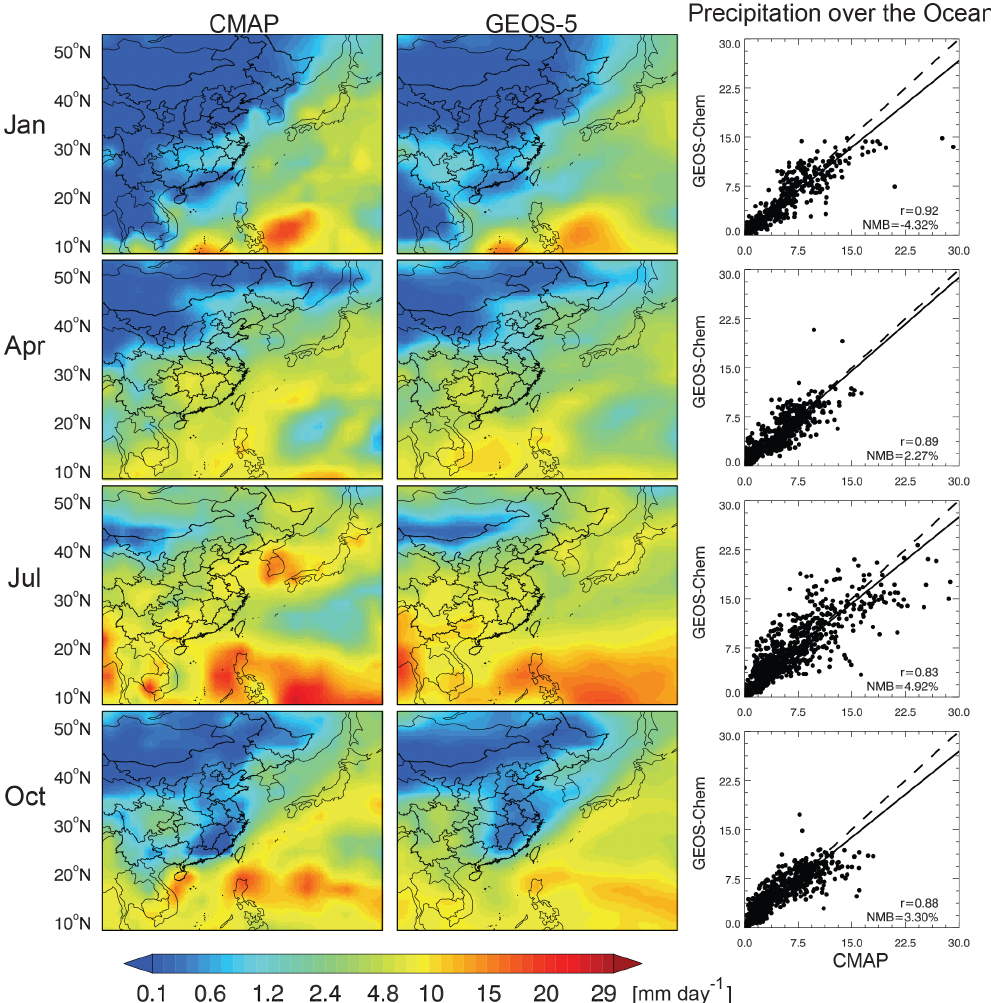
Figure 4. Monthly mean precipitation data from CMAP (left panels) and from GEOS-5 (central panels) for January, April, July, and Octo- ber 2009. The right panels show corresponding scatter plots of CMAP versus GEOS-5 precipitation over the northwestern Pacific Ocean. Correlation coefficients ( r ) and mean normalized biases (NMB) are shown